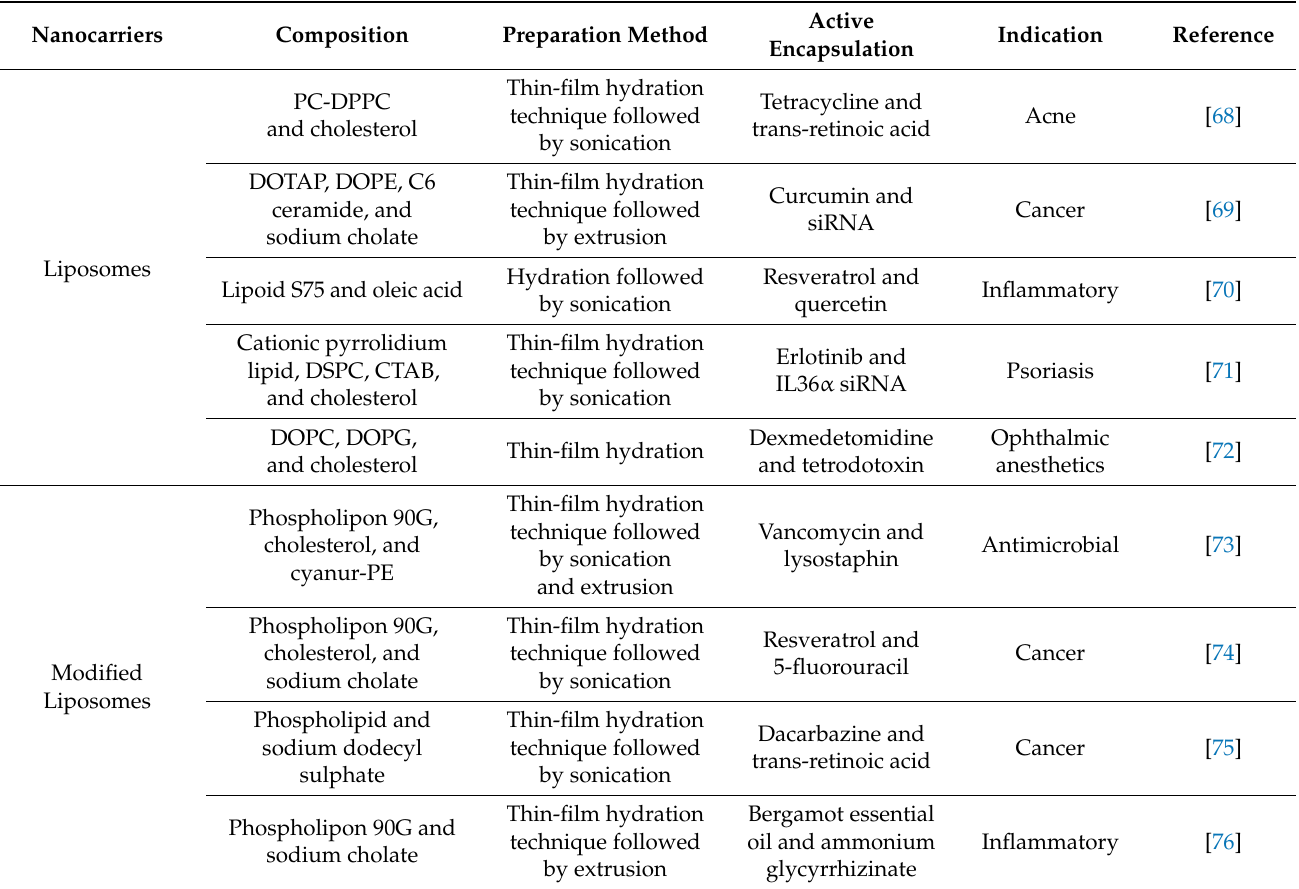
Table 3. Examples of the liposomes and modified liposomes and the diseases that can benefit from co-encapsulated